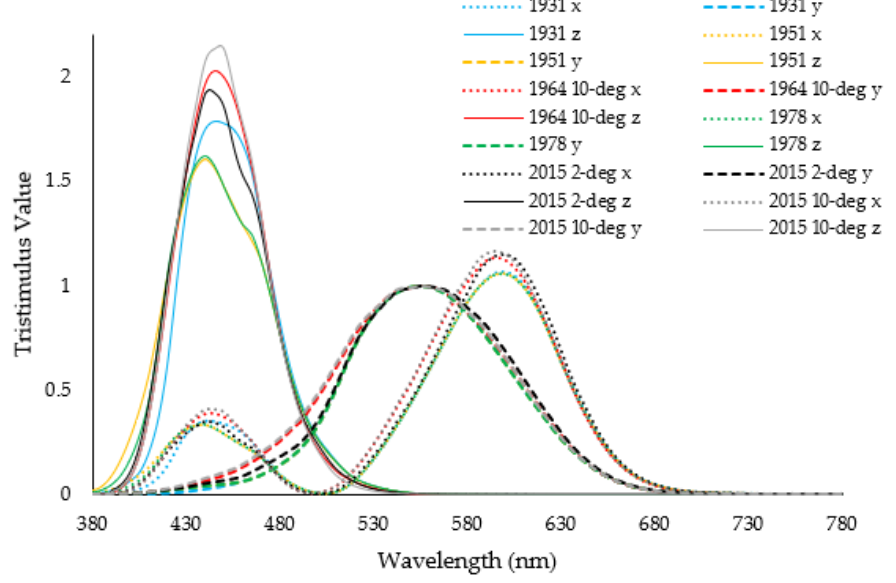
Figure 2. The CIE 1931 (blue lines), 1951 Judd version (yellow lines), CIE 1964 10-degree (red lines), 1978 Vos version (green lines), CIE 2015 2-deg (black lines), and CIE 2015 10-deg (gray lines) color matching functions. Dotted lines are long-wavelength, dashed lines are middle-wavelength, and continuous lines are short-wavelength CMFs.